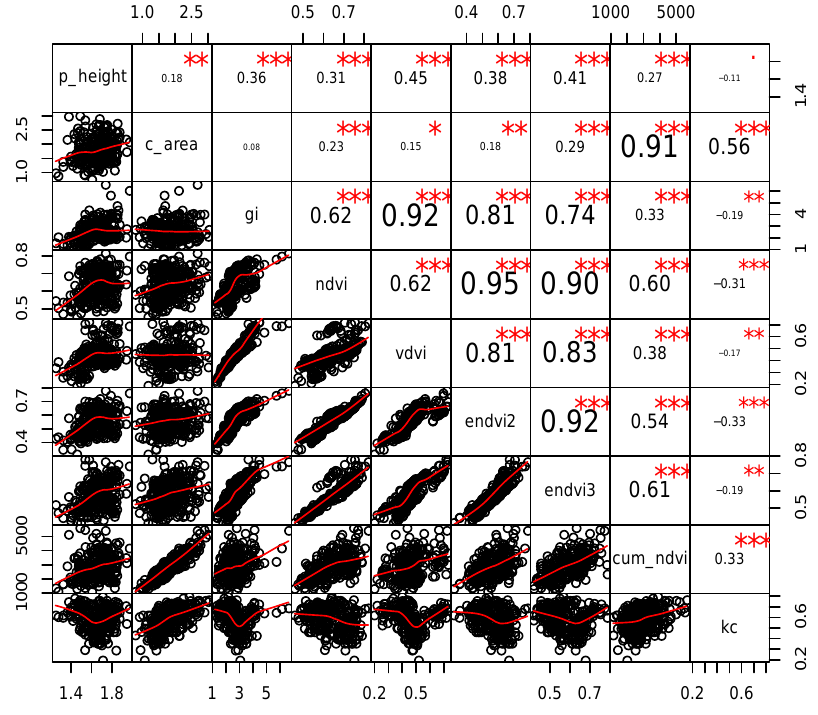
Figure 7. Correlogram showing the scatter plot, correlation coefficient values and statistical signifi- cance (Pearson test: p -value < 0.05 as *, p -value < 0.01 as **, and p -value < 0.001 as ***) between the selected features (spectral and structural) and the crop